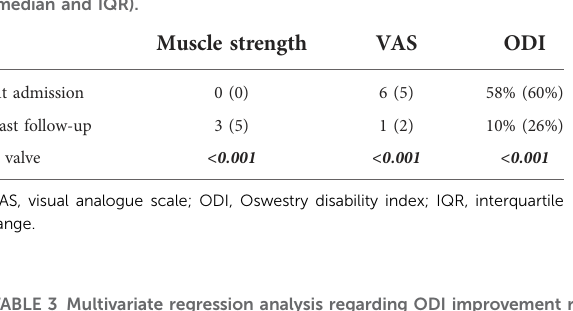
TABLE 3 Multivariate regression analysis regarding ODI improvement rate.